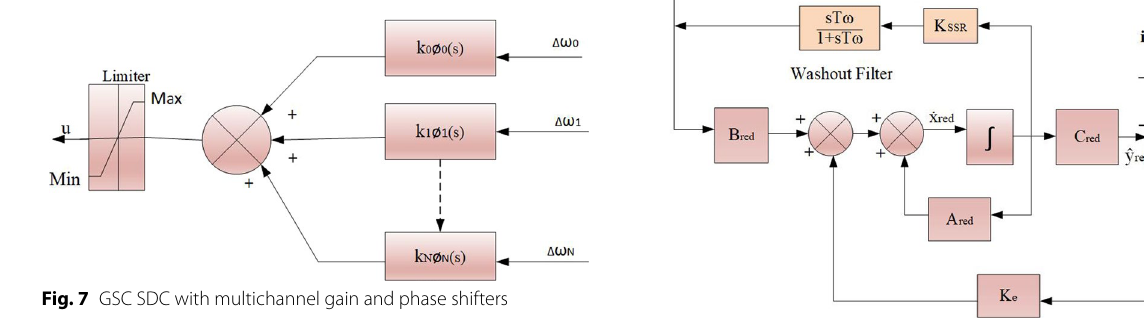
Fig. 9 State-feedback controller, LQR as state